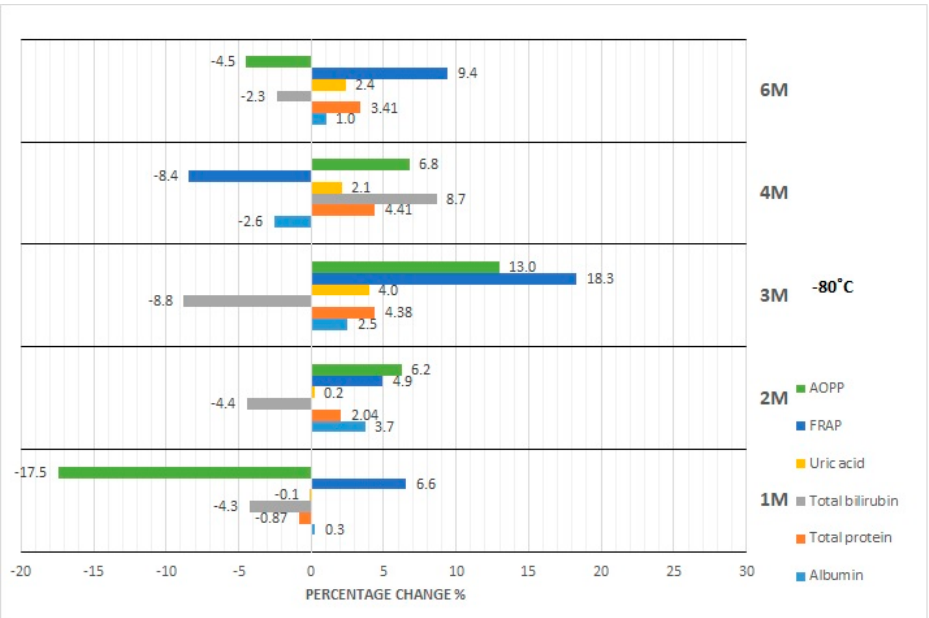
Figure 2. Percentage changes in concentration of selected parameters after storage of serum samples for 1–6 months (1M-6M) at − 20 °C. AOPP—advanced oxidation protein products, FRAP—ferric reducing ability of plasma, UA—uric acid, Bil—bilirubin, TP—total protein, Alb—albumin. Diagnostics 2019 , 9 , x FOR PEER REVIEW